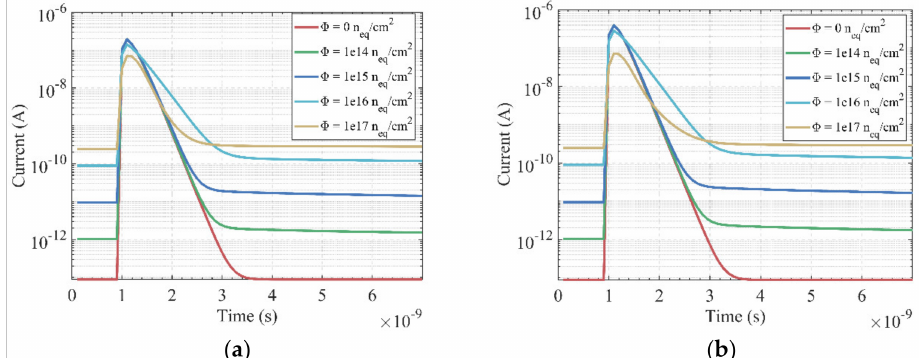
Figure 8. I-t curves with varying radiation fluences; ( a ) particle incident position R = 10 µ m and the incident depth is 5 µ m; ( b ) incident position R = 10 µ m and the incident depth is 10 µ